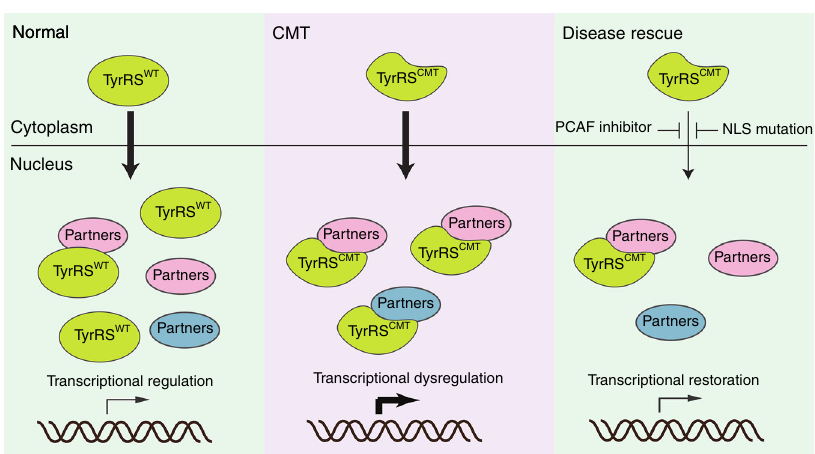
Fig. 6 Schematic illustration of the proposed TyrRS mode of action. TyrRS enters the nucleus and engages with different interaction partners, including transcription factors. CMT-causing mutations do not affect the nuclear translocation of TyrRS. However, when the mutant protein enters the nucleus, these interactions are enhanced or perturbed and new interactions may be formed, leading to dysregulation of the transcriptional machinery. As demonstrated in a Drosophila model, the dysregulation can be alleviated by inhibiting the nuclear entry of TyrRS pharmacologically or